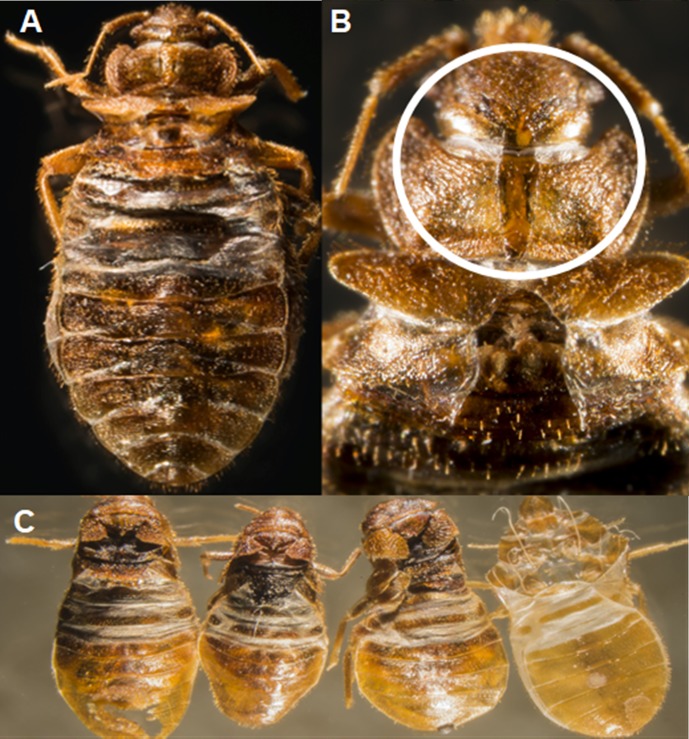
A. A large nymph that survived heat exposure, but was unable to complete the molting process. B. A magnified view of a heat exposed bed bug shown in the left image. This insect was attempting to molt, but failed to escape its exoskeleton. The epicranial suture is circled in white appears to have opened, but the bed bug failed to escape through it. C. Depicted in the image from left to right are three heat exposed nymphs that failed to successfully molt to next instar after heat exposure. On the right is an exuvia from a nymph that did successfully molt. Photo credit: John Obermeyer.